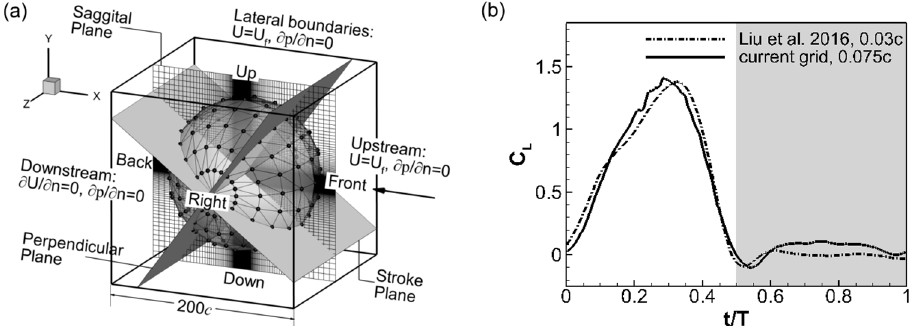
Figure 3. ( a ) The computational doamin, boundary conditions, acoustic probe (black dots) setup and the reference planes and positions. ( b ) Comparison of the lift coefficient computed with two different grids.